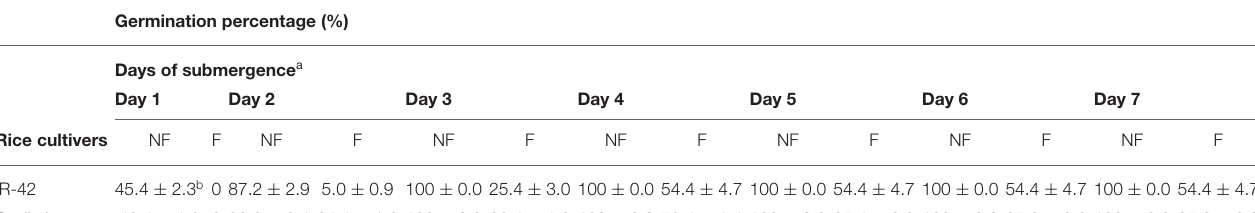
TABLE 1 | Germination percentage of different rice cultivars during 7 days submergence. Germination percentage (%)